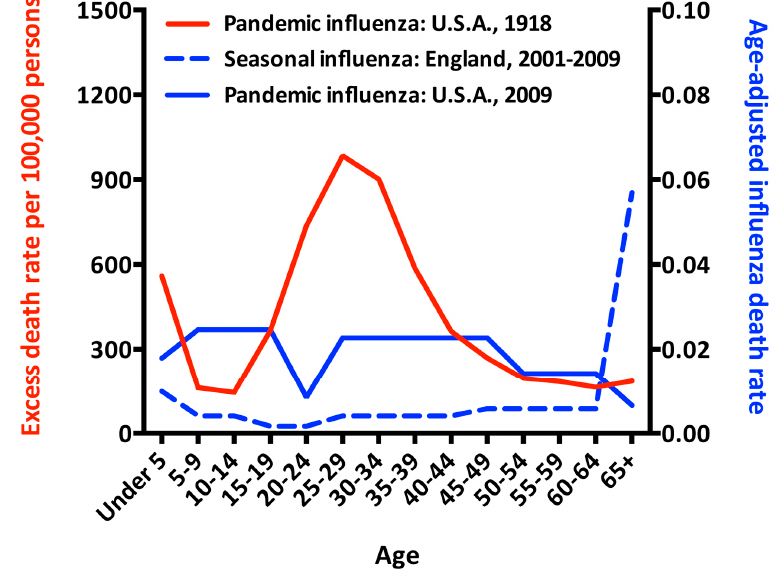
Figure 2. Influenza deaths in pandemic and epidemic influenza. Data from the pandemic year of 1918 are graphed against the left y-axis as the excess death rate above the baseline death rate observed in the non-pandemic year of 1914 [93]. Data from 2001–2009 are graphed against the right y-axis as the age-adjusted death rate (AADR), calculated as follows: Influenza-attributed crude death rate per 100,000 population (CDR) = the number of influenza deaths in each age group ÷ the population in that age group × 100,000; AADR = CDR × the proportion of the entire population within that age group. Influenza death counts by age group were obtained from published data for the U.S. [95] and England [94]. U.S. census figures from 2010 [96] and U.K. national population estimates for England (code E92000001) in mid-year 2005 [97] were used to approximate the number and age distribution of the population at risk during each time period.